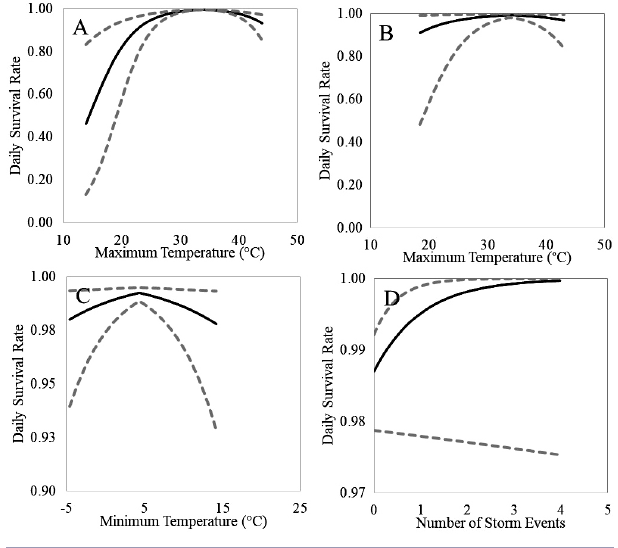
Fig. 4. Influence of variables included in the best model, with 95% confidence intervals or standard errors, on predicted daily survival rate (DSR; left) for Piping Plover nests (A) and broods